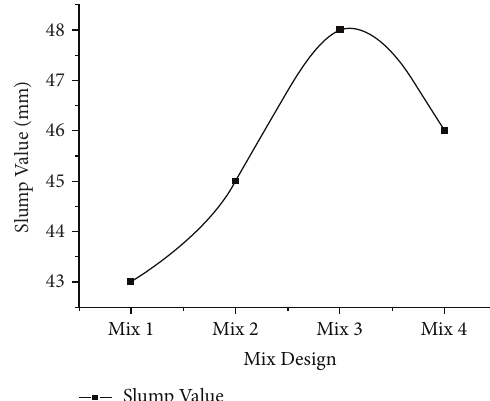
Figure 5: Graph of slump value for different mixes.